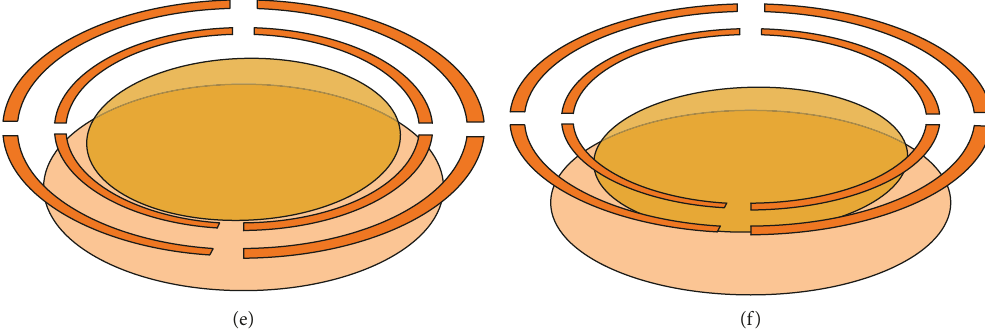
Figure 5: Different locations of the APMS. (a) With small APMS. (b) With large APMS (c) Location 1. (d) Location 2. (e) Location 3. (f) Location